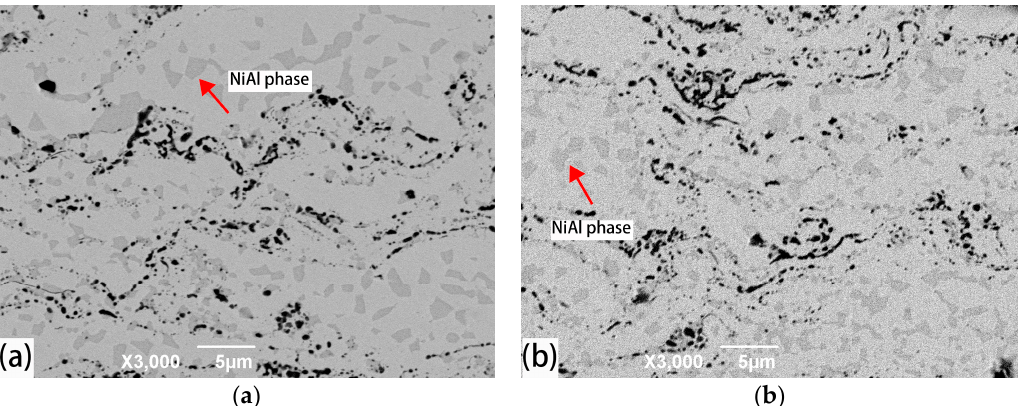
Figure 4. The internal morphology of the oxidation layer after being isothermal-oxidized for 200 h: ( a ) type A and ( b ) type B.